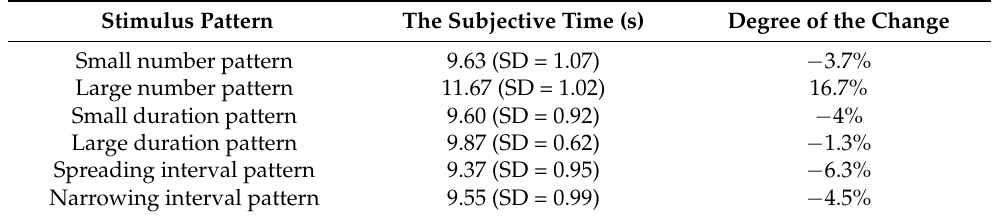
Table 1. Results of Experiment 4. Degree of change in the subjective time for each stimulus